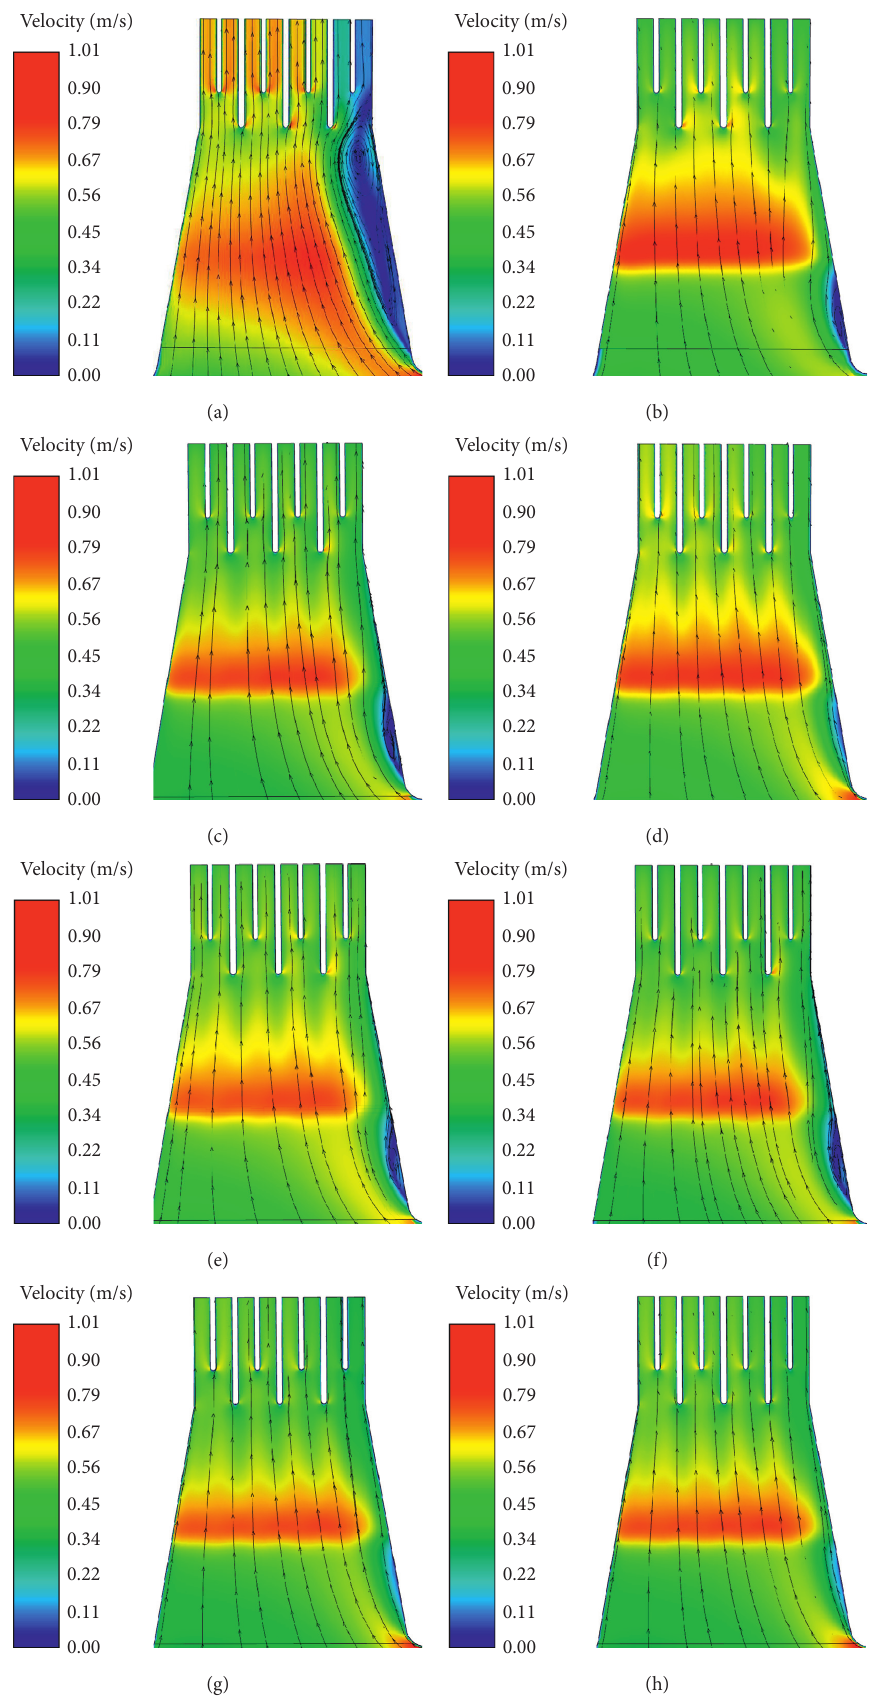
Figure 9: Surface flow field diagram of each plan: (a) plan 1, (b) plan 2, (c) plan 3, (d) plan 4, (e) plan 5, (f) plan 6, (g) plan 7, and (h) plan